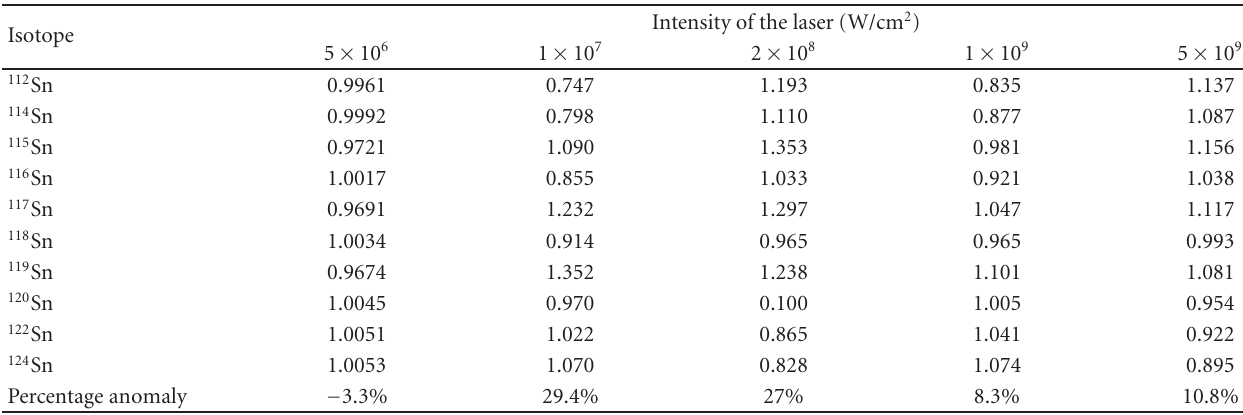
Intensity of the laser (W/cm 2